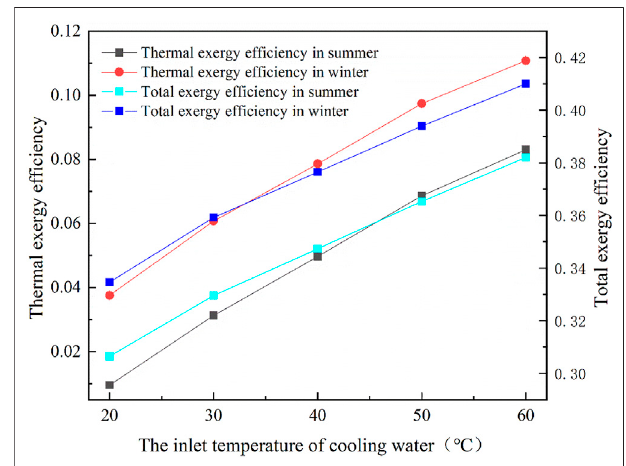
FIGURE 11 | In fl uence of the inlet fl ow on the electrical ef fi ciency and thermal ef fi ciency.